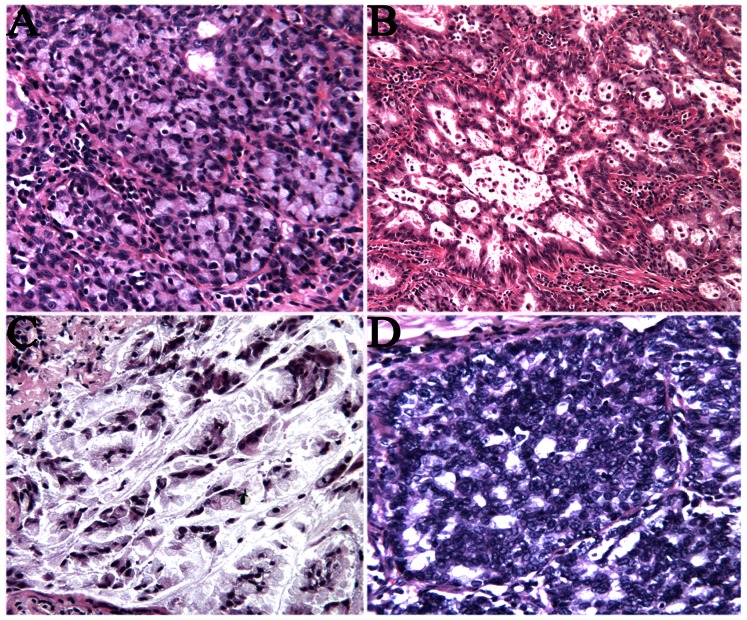
Comparison between ALK immunohistochemical staining and fluorescence in situ hybridization signals.
A, C, E, G: ALK immunostainings (original magnification ×200). A and C: intense and moderate cytoplasmic stainings (score = 3 and 2 respectively), E: weak cytoplasmic stainings (score = 1 ) and G: no staining (score 0). B, D, F and H. FISH analysis for ALK using a dual-color ALK break-apart probe. B, D and F show FISH sigals in the ALK-rearranged tumors, and the proportion of cells with ALK positive signals was 49%(49/100), 38%(38/100), 56%(28/50), respectively. Rearranged ALK (B, D,and F) is indicated by splitting of red and green signals or single red signals.H shows FISH sigals in a non-rearranged tumor. the proportion of cells with ALK positive signals was 3%(3/100). Non-rearranged ALK (H) shows fusion or adjacent red and green signals.